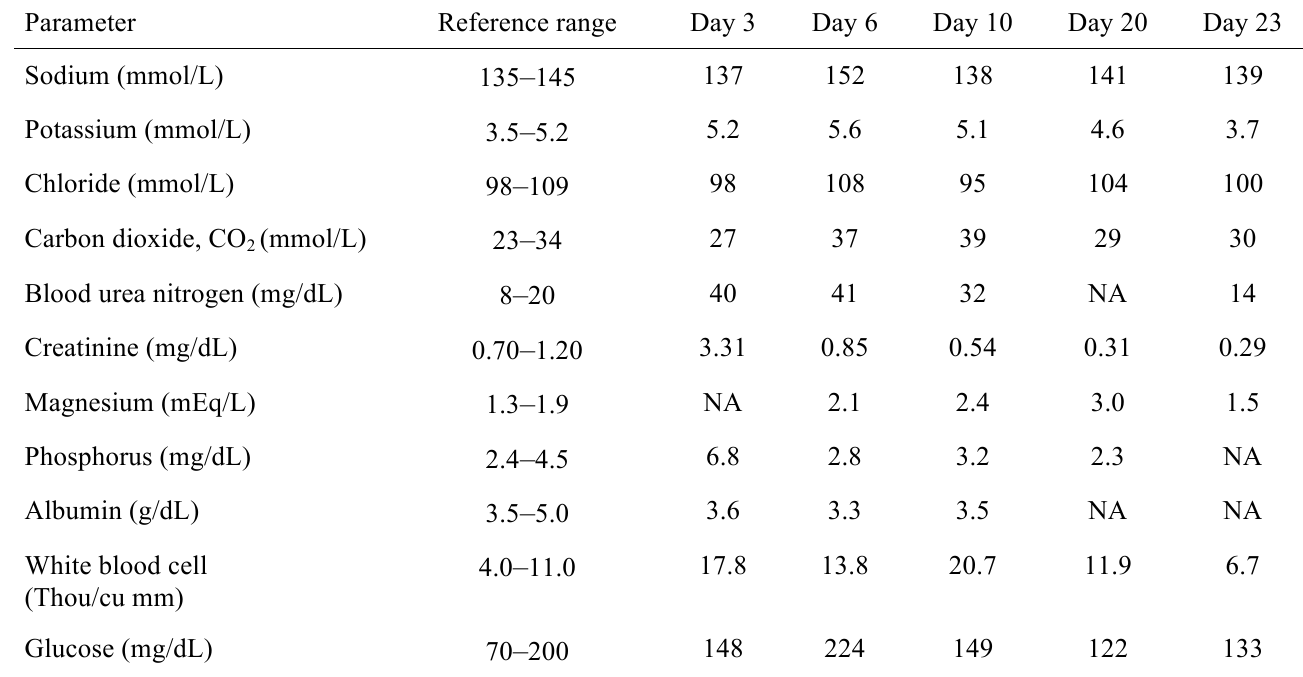
Table 1 Biochemical data